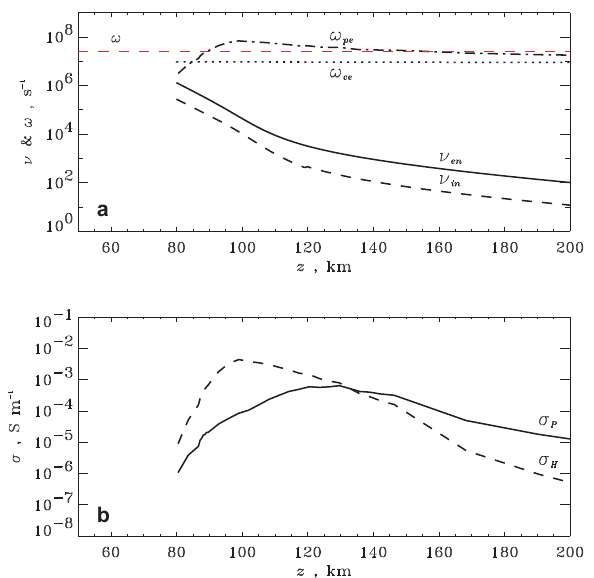
Fig. 3. (a) Electron-neutral (solid line) and ion-neutral collision fre- quencies (dashed line), electron plasma frequency (dashed-dotted line) and gyrofrequency (dotted line), HF pump frequency (dashed horizontal line), (b) the Pedersen (solid line) and the Hall (dashed line) conductivities which correspond to the ionospheric conditions of Fig.